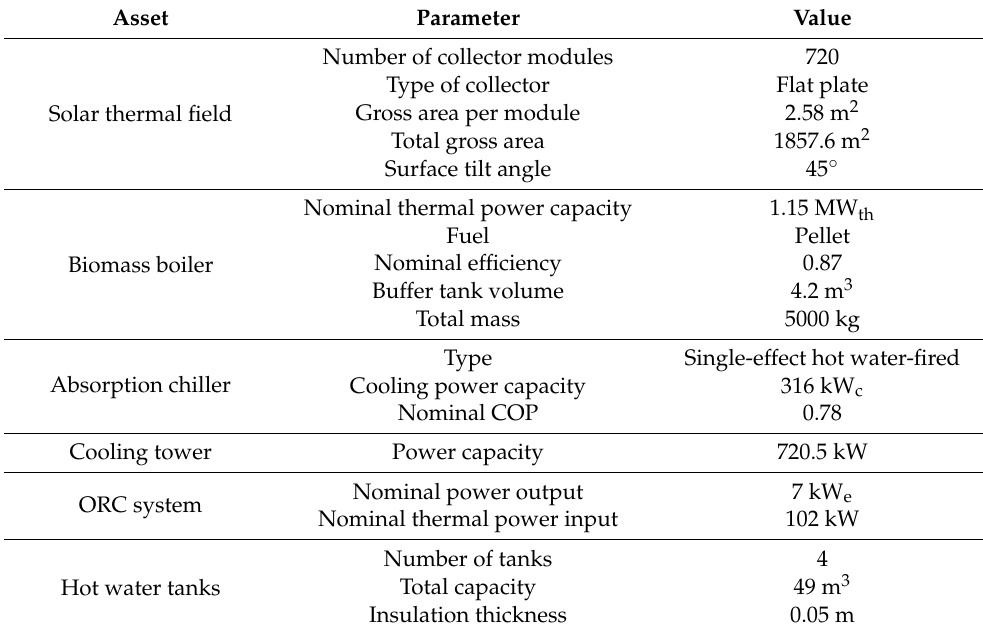
Table 1. Main parameter values of the thermal grid.